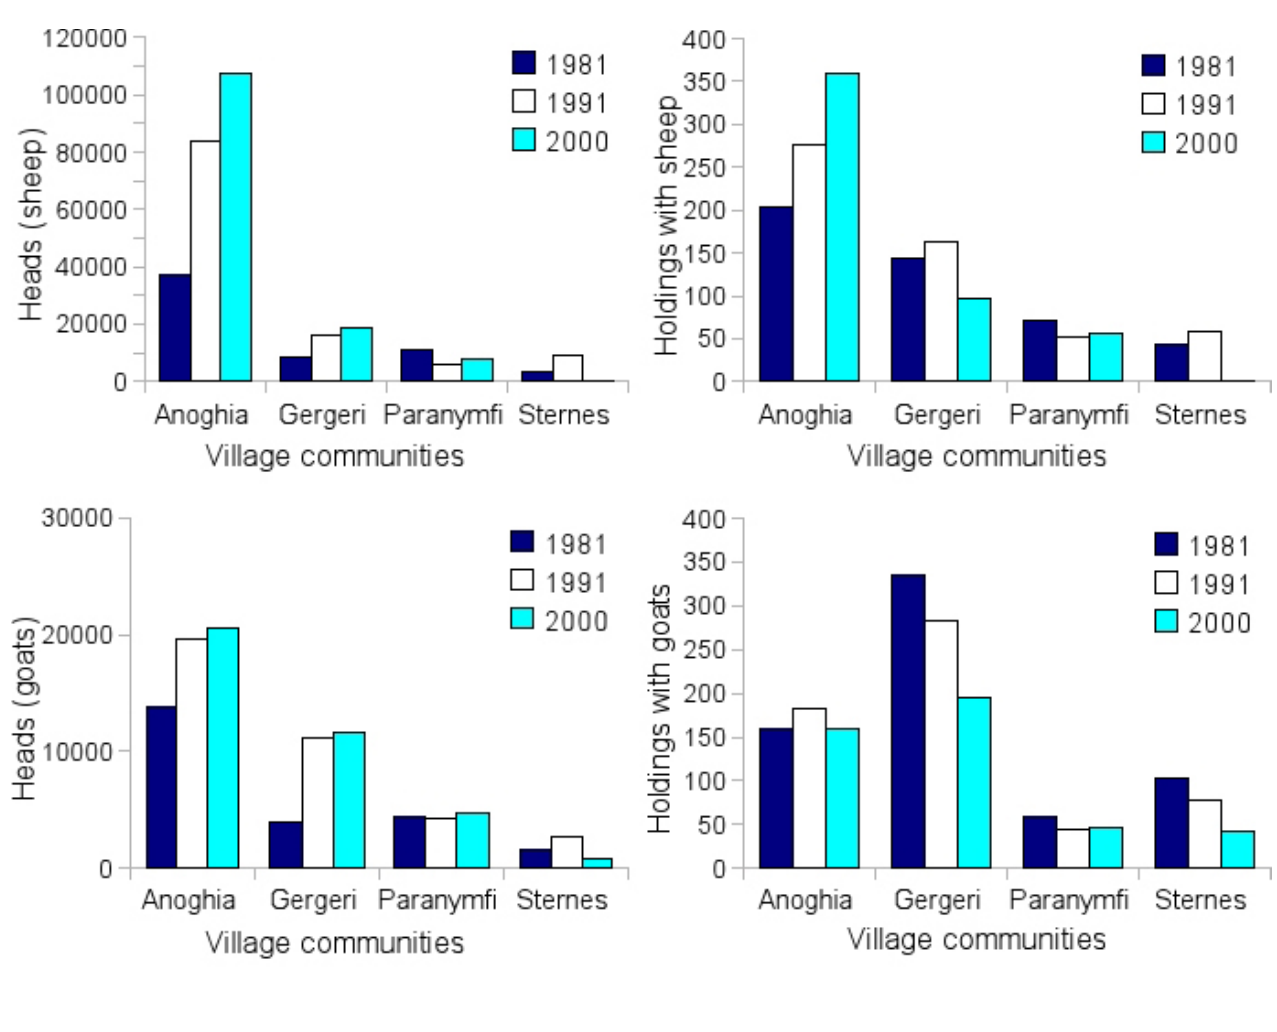
Figure 2. Sheep and goat farms and flock size in the four surveyed municipalities according to the Greek agricultural censuses of 1981, 1991, and 2000 (data about sheep holdings for 2000 are missing for